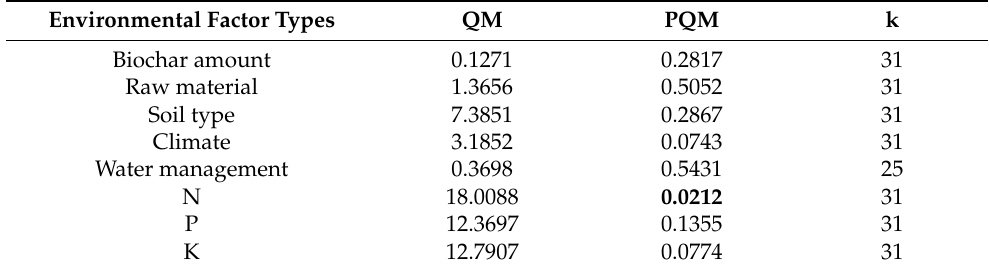
Table 4. Factors affecting CH 4 emissions from paddy soils under biochar incorporation scenario.